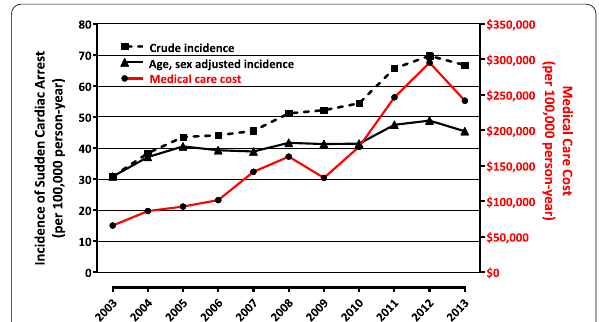
Fig. 1 Annual incidence and medical care cost of sudden cardiac arrests per 100,000 persons in South Korea from 2003 to 2013. The medical care cost was adjusted for the inflation rate in South Korea. p < 0.001 for trends for all variables